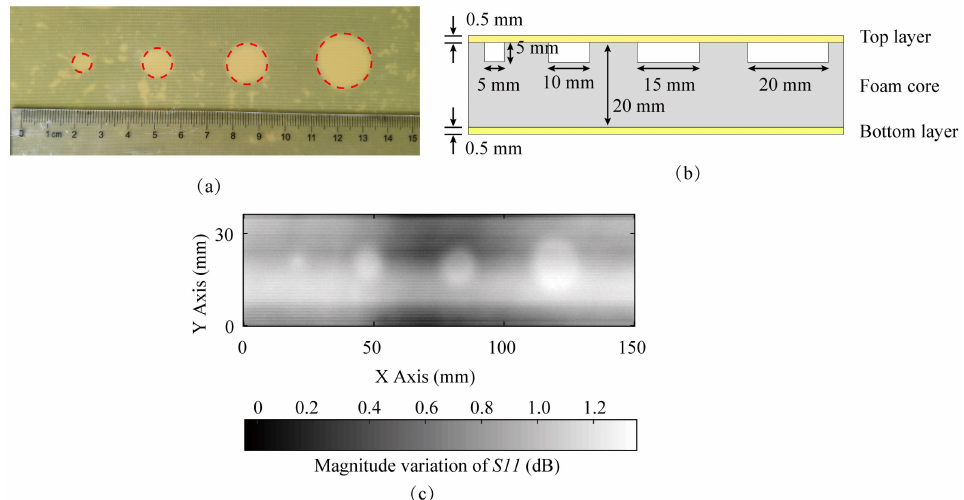
Figure 16. ( a ) The picture for sample 1 which is a multilayer composite board, and four holes of di ff erent diameters are drilled in its foam core; ( b ) the cutaway view of the sample 1; ( c ) the image gained by the magnitude variation.